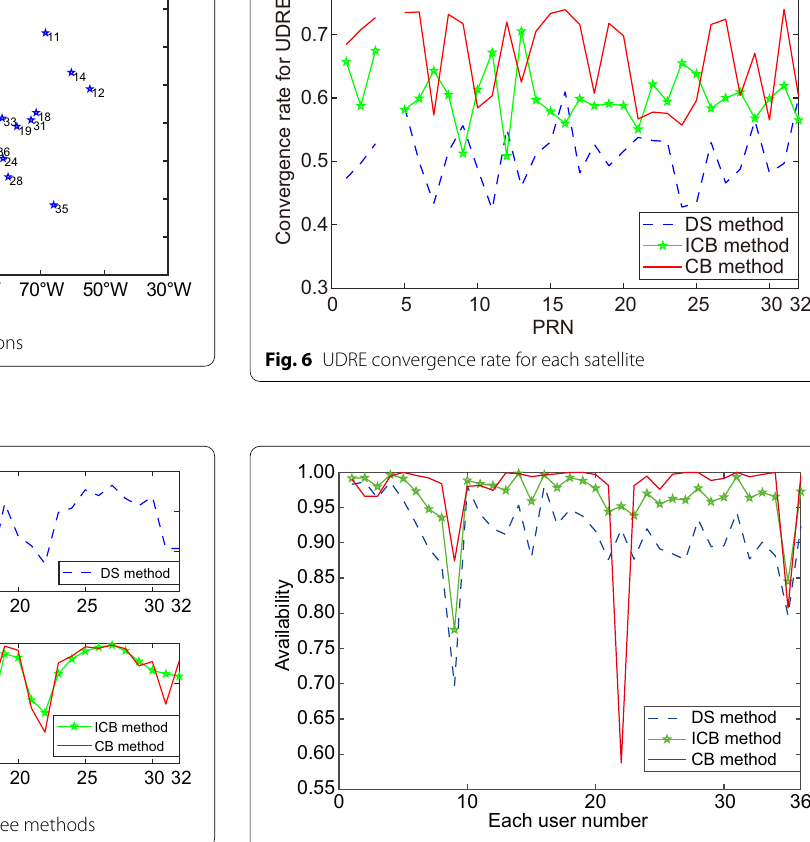
Fig. 7 Availability of LPV200 service at each selected